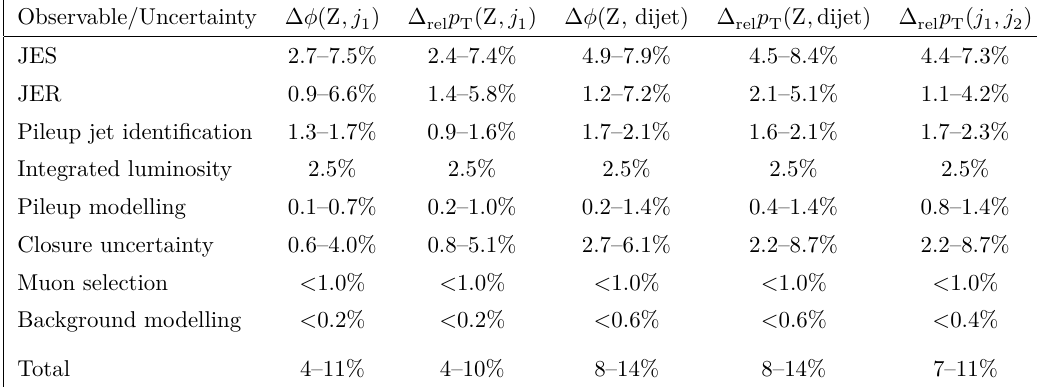
Table 3 . Uncertainty sources and their effect on the differential cross section distributions.